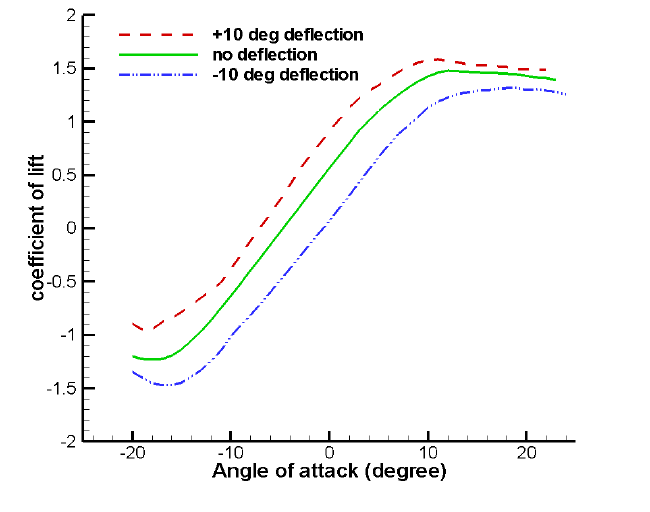
Figure 3. C vs . α of NACA64618 airfoil with 0° and ±10° flap l